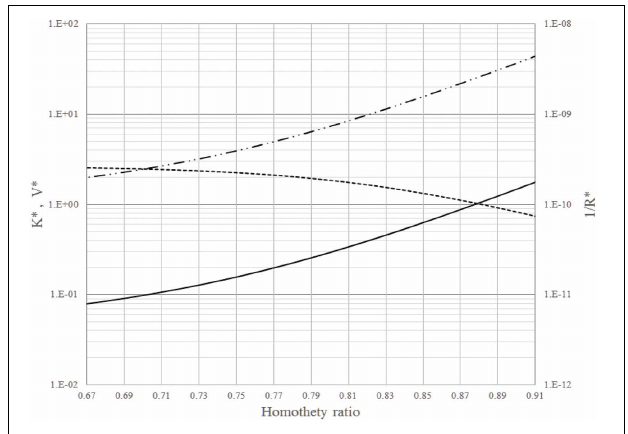
FIGURE 2 | Dimensionless intrinsic permeability ( _______ ), volume ( __ .. __ .. __ ), and global permeation ( __ __ __ ) vs. the homothety ratio (i.e., reduction factor between parent and daughters vessels): from the 16th to the 23rd generations of branches in the dendritic network.